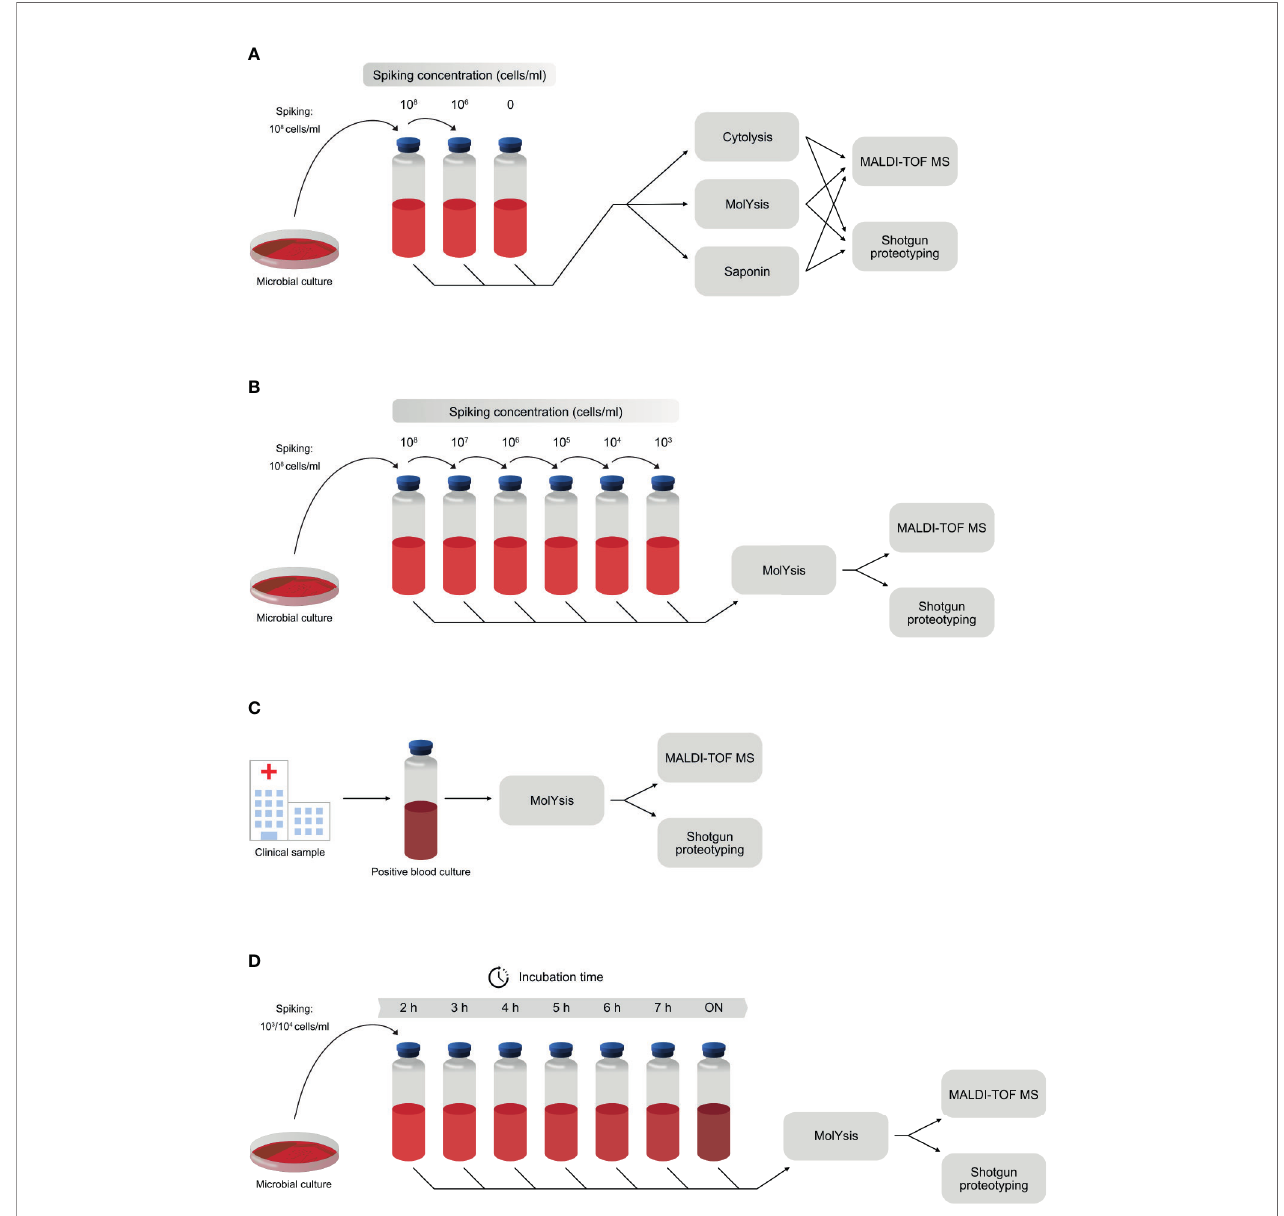
FIGURE 1 | The experimental design of the experiments included in the study. (A) Host depletion methods MolYsis, Saponin and Cytolysis were investigated by spiking negative blood with different numbers of cells from S. aureus . (B) Assessment of the sensitivity of shotgun proteotyping, compared with direct MALDI-TOF MS-based identi fi cation. Different numbers of cells were added to negative blood samples in the range of 1,000 cells/ml to 100 million cells/ml, and the samples were then analyzed by both methodologies. (C) Assessment of the accuracy of shotgun proteotyping and direct MALDI-TOF MS-based identi fi cation by analysis of positive blood cultures from the clinical routine laboratories. (D) Assessment of the incubation time needed for a positive identi fi cation of the correct species, using shotgun proteotyping and direct MALDI-TOF MS-based identi fi cation. A low number of cells (1,000 or 10,000) was added to negative blood samples, followed by incubation in a blood culture cabinet. Samples were taken after 2, 3, 4, 5, 6 and 7 hours of incubation, as well as after overnight